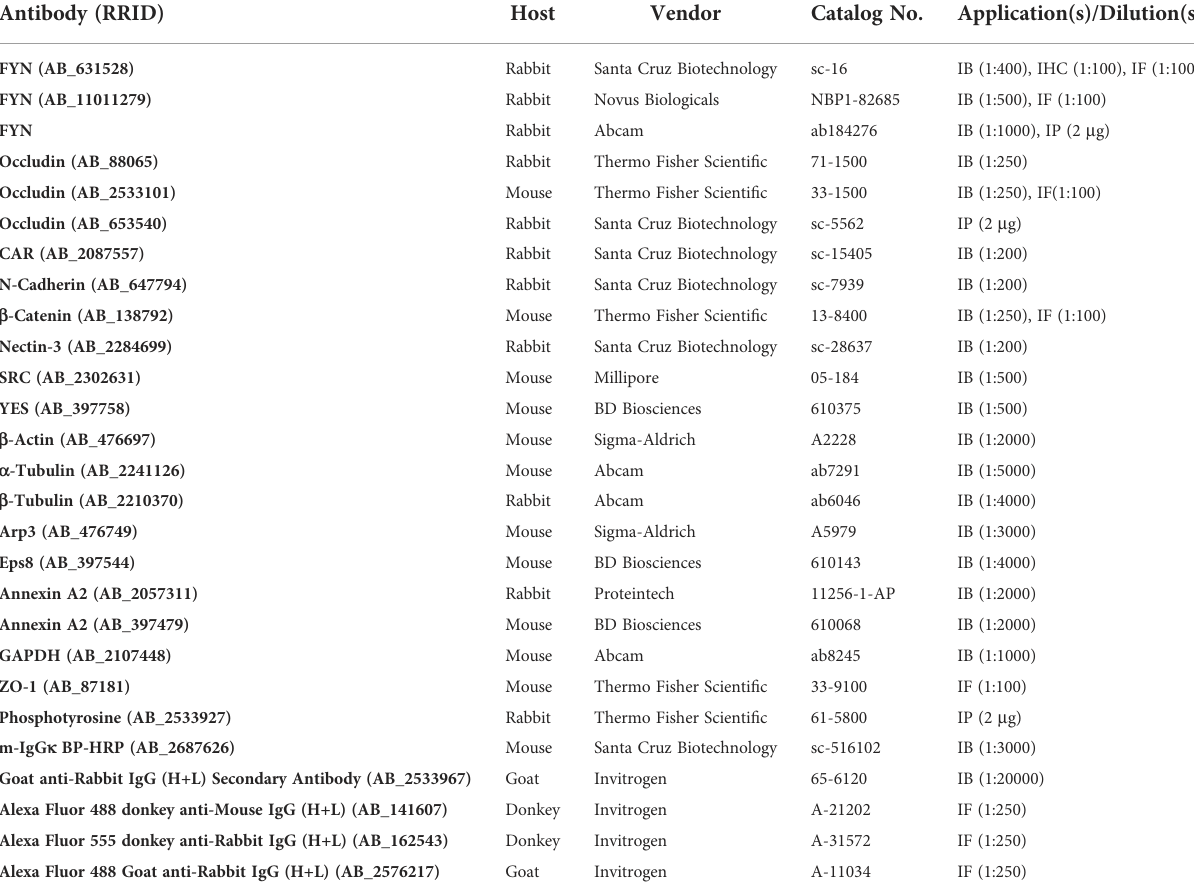
TABLE 1 Antibodies used in this study. Antibody (RRID) Host Vendor Catalog No. Application(s)/Dilution(s)